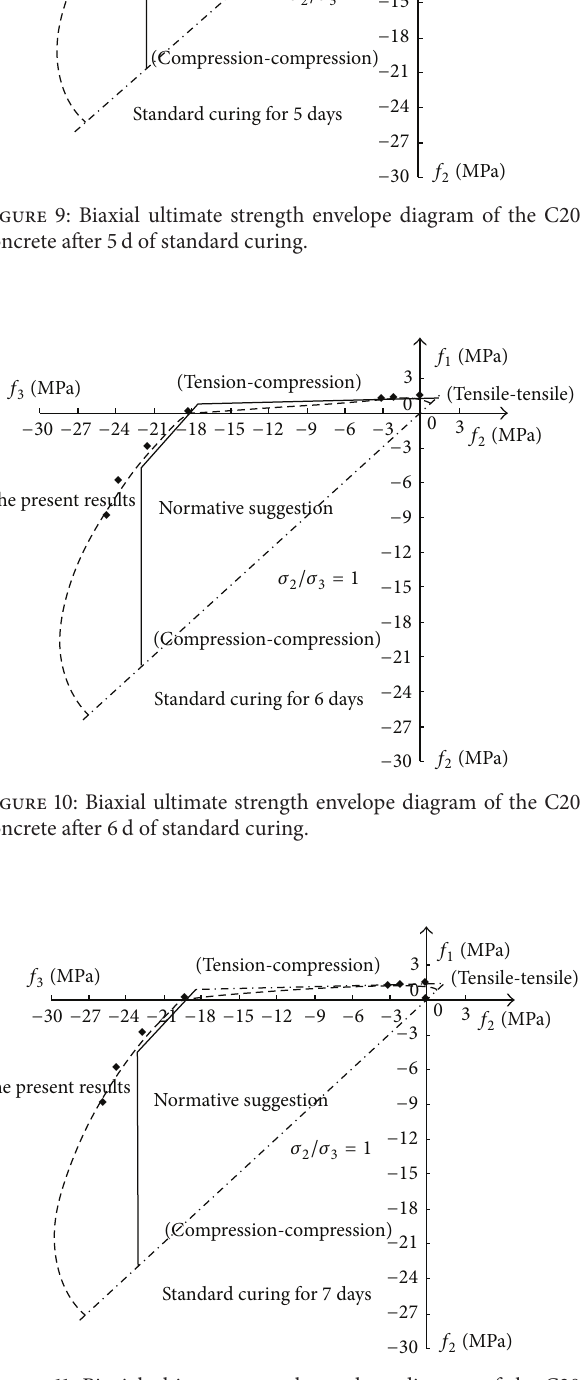
Figure 11: Biaxial ultimate strength envelope diagram of the C20 concrete after 7 d of standard